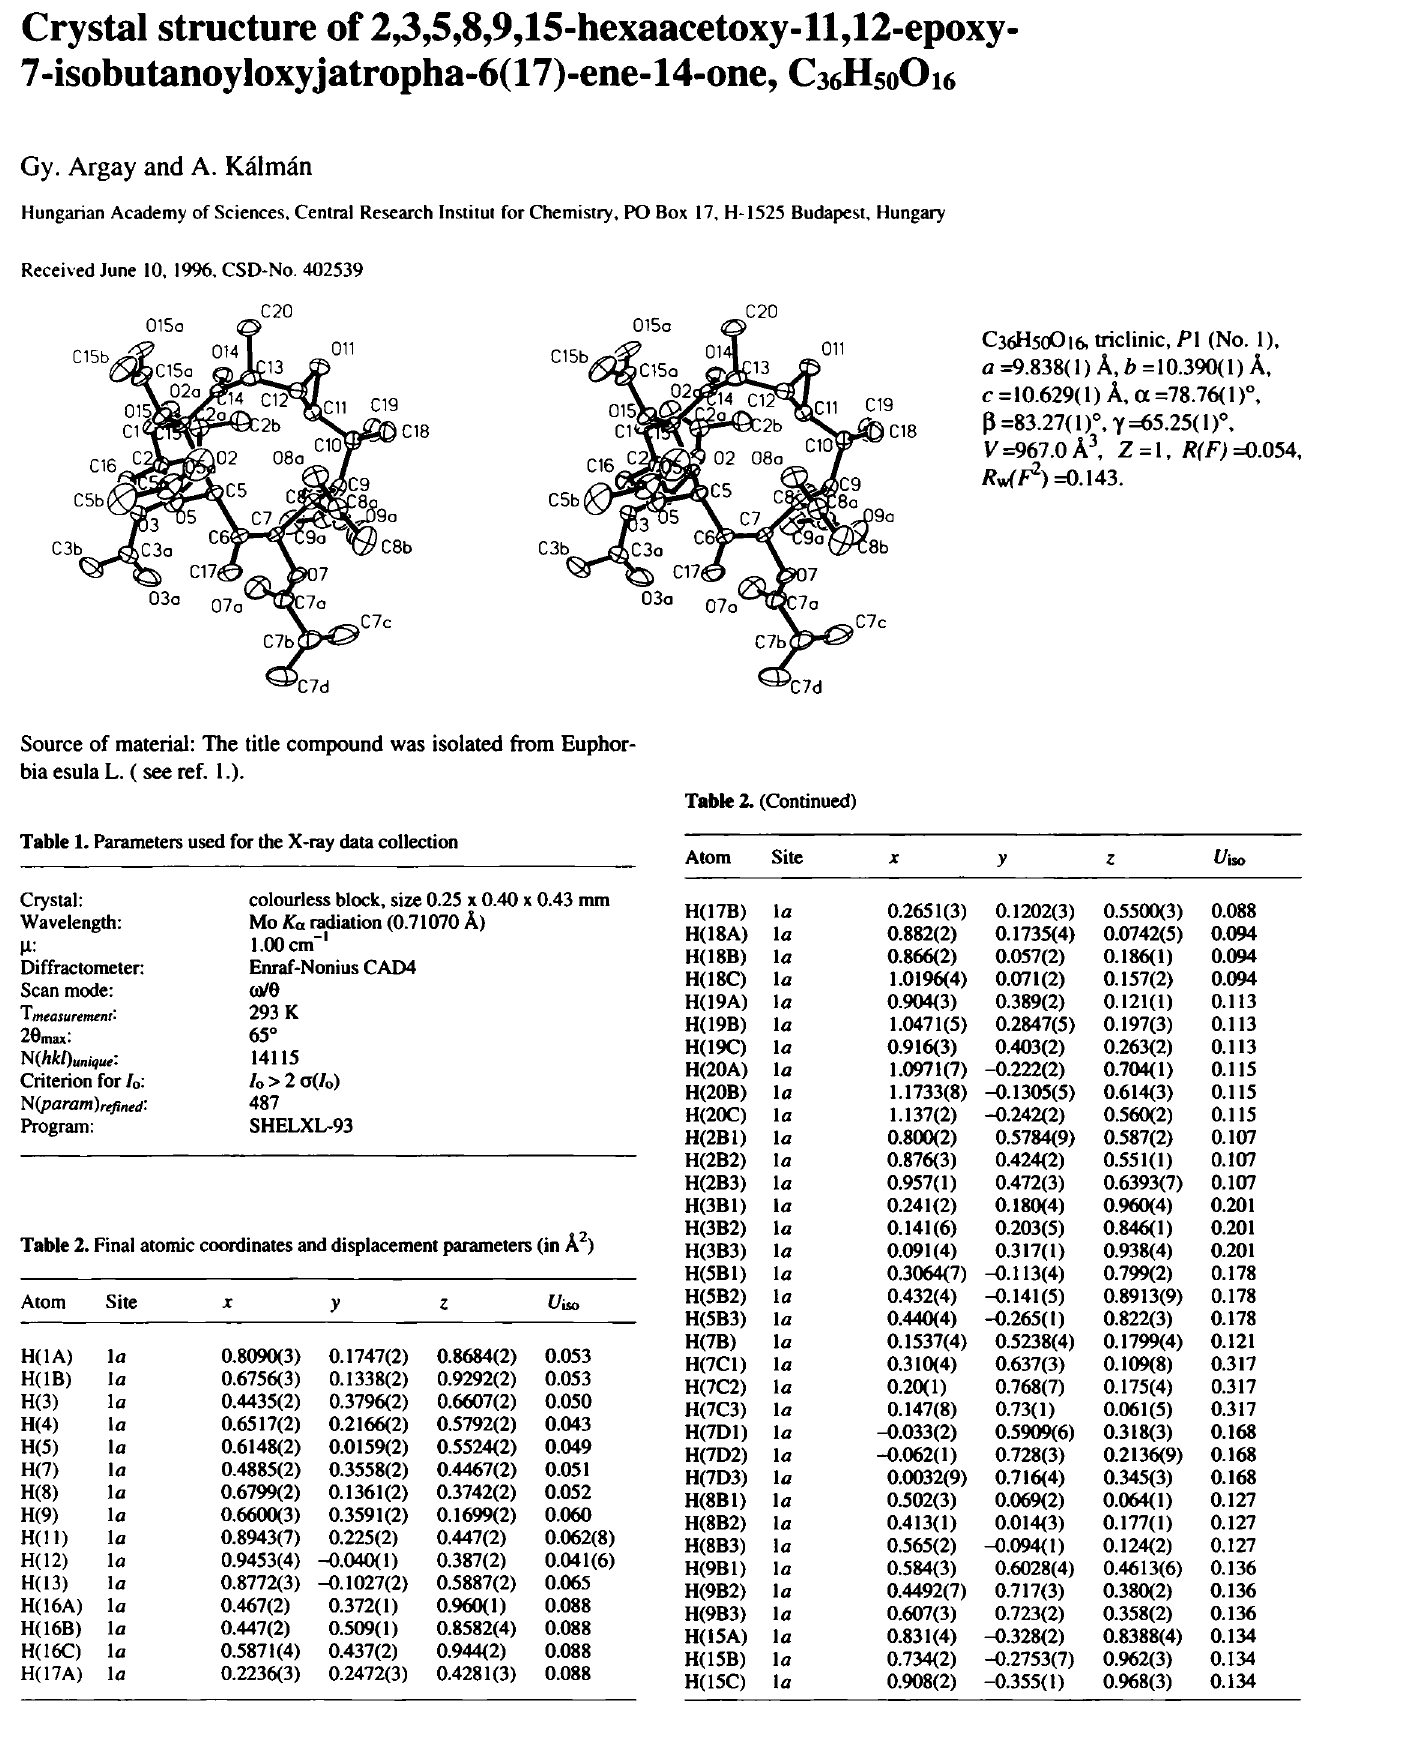
Table 1. Parameters used for the X-ray data collection